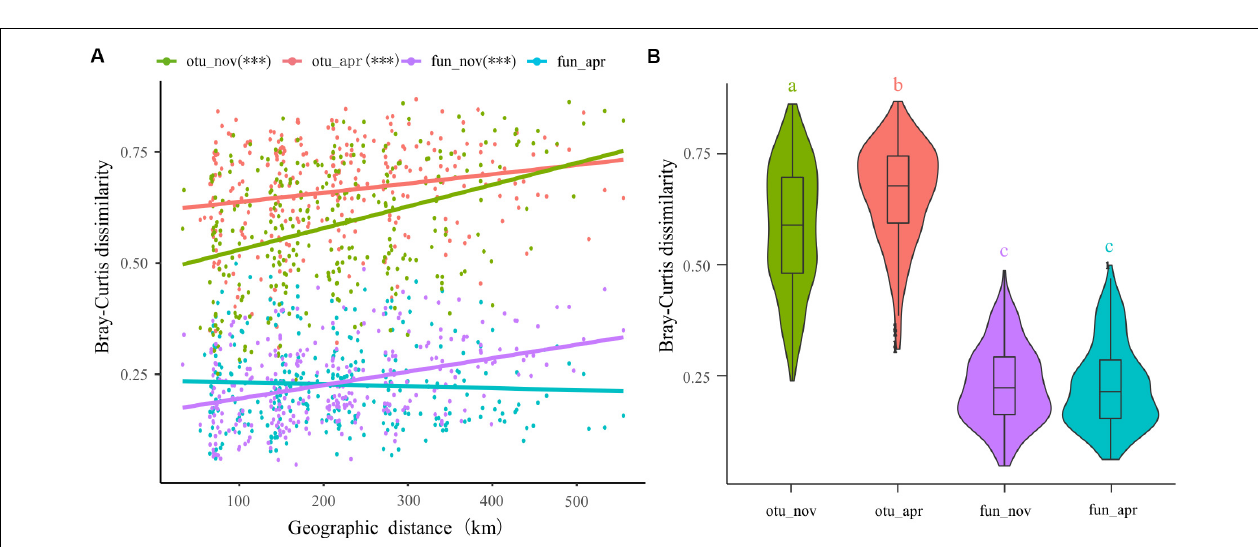
FIGURE 7 | Distance-decay of similarities in taxonomy and function of bacterioplankton communities in different seasons. (A) Corrections between Bray–Curtis dissimilarities with geographic distance between sites. (B) The spatial dissimilarities in bacterioplankton taxonomic composition and functional composition.